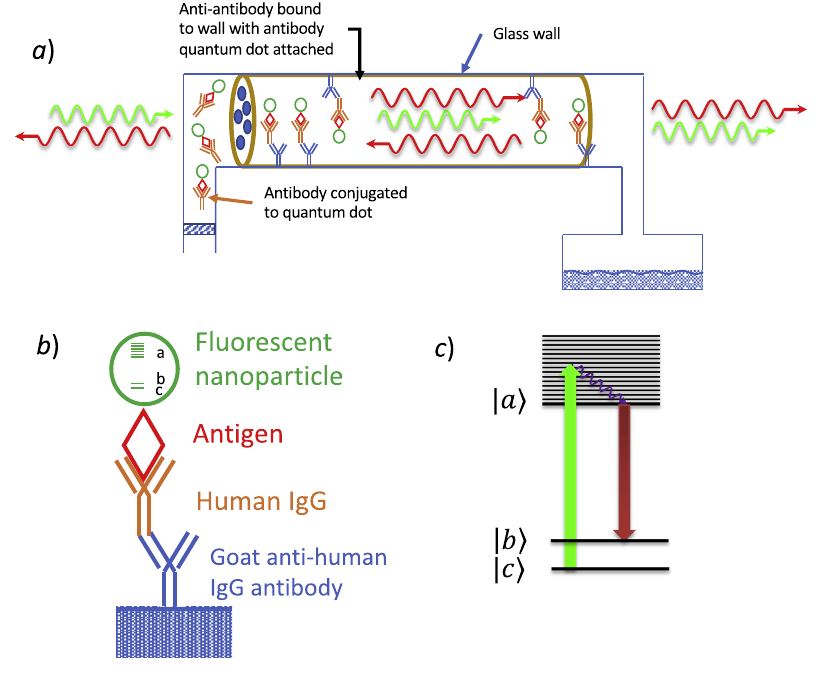
Figure 3: (a) Depicts anti-antibody + antibody-quantum pairs stuck to wall, with theboundpaircon fi gurationshownin(b)and the Raman level structure shown in